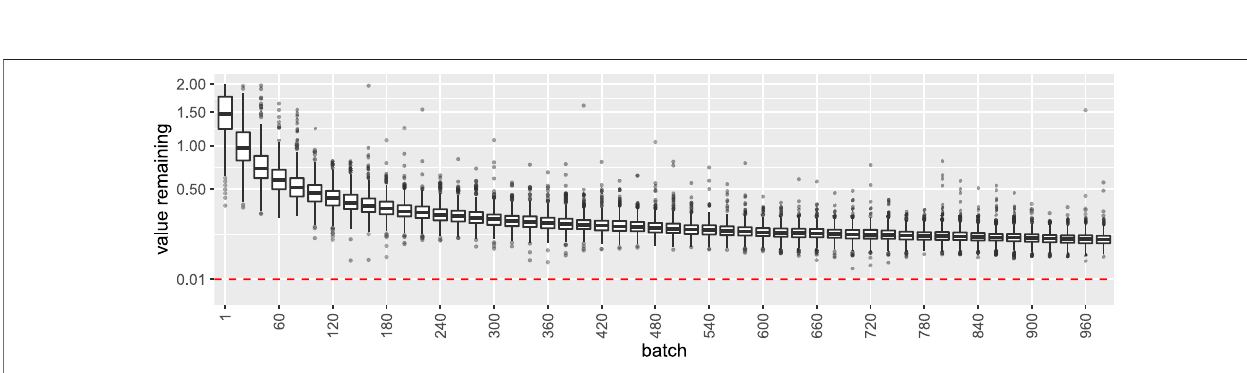
FIGURE6| Distribution ofthemetric valueremaining fortheNullcaseofall k (cid:1) 10armsbeingequal( p i (cid:1) 0 . 05).Withauniformprior,notasingleexperiment ended earlier than the maximum number of iterations, i.e. the lower bound of 0.01 was never crossed!